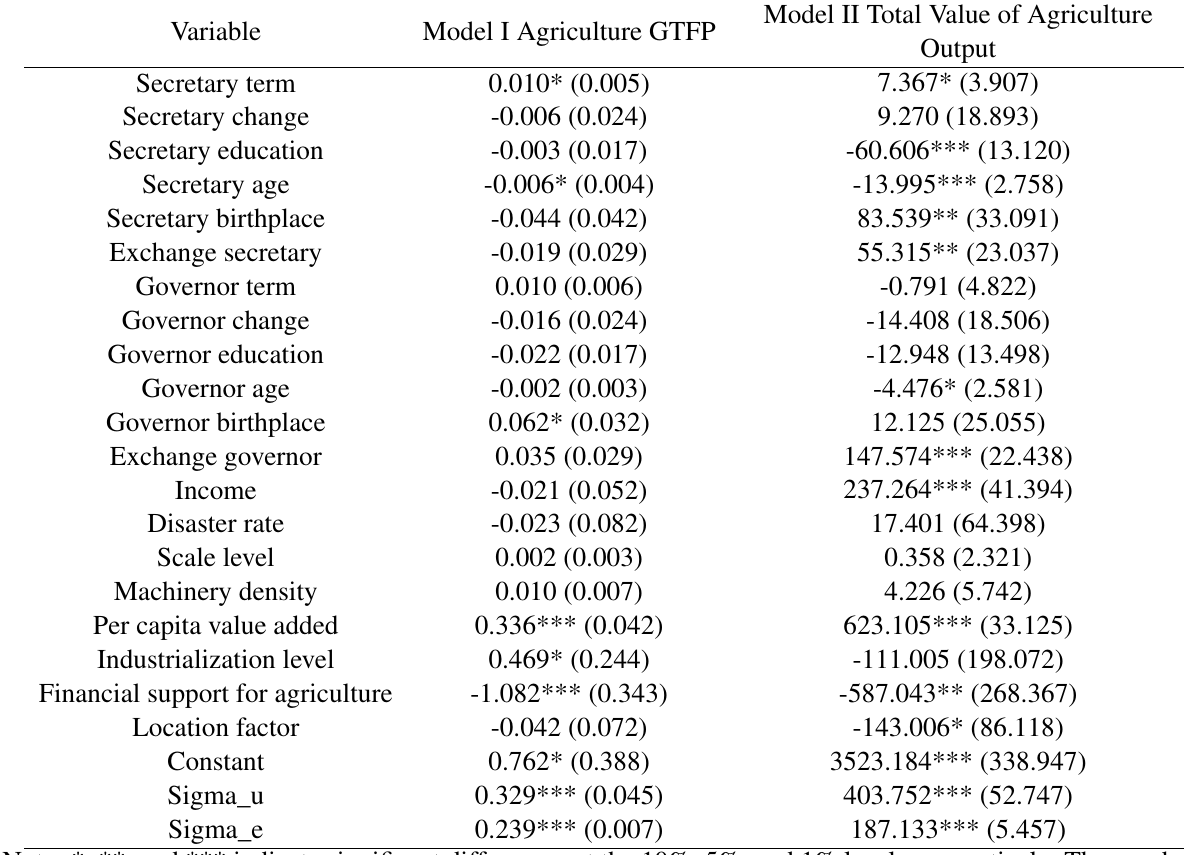
Table 5 Impacts of officials on agricultural